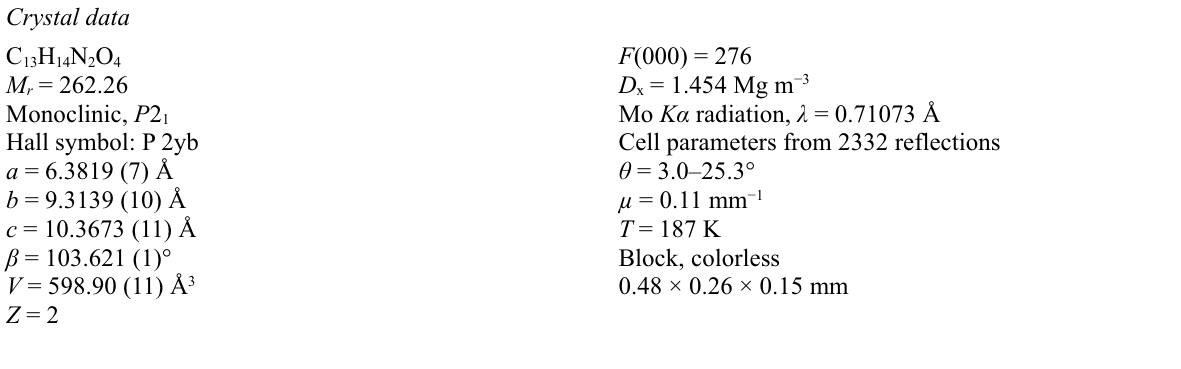
The structure of the title compound, showing 30% probability displacement ellipsoids and the atom-numbering scheme. (11aS)-8-Hydroxy-7-methoxy-2,3,5,10,11,11 a -hexahydro-1 H - pyrrolo[2,1- c